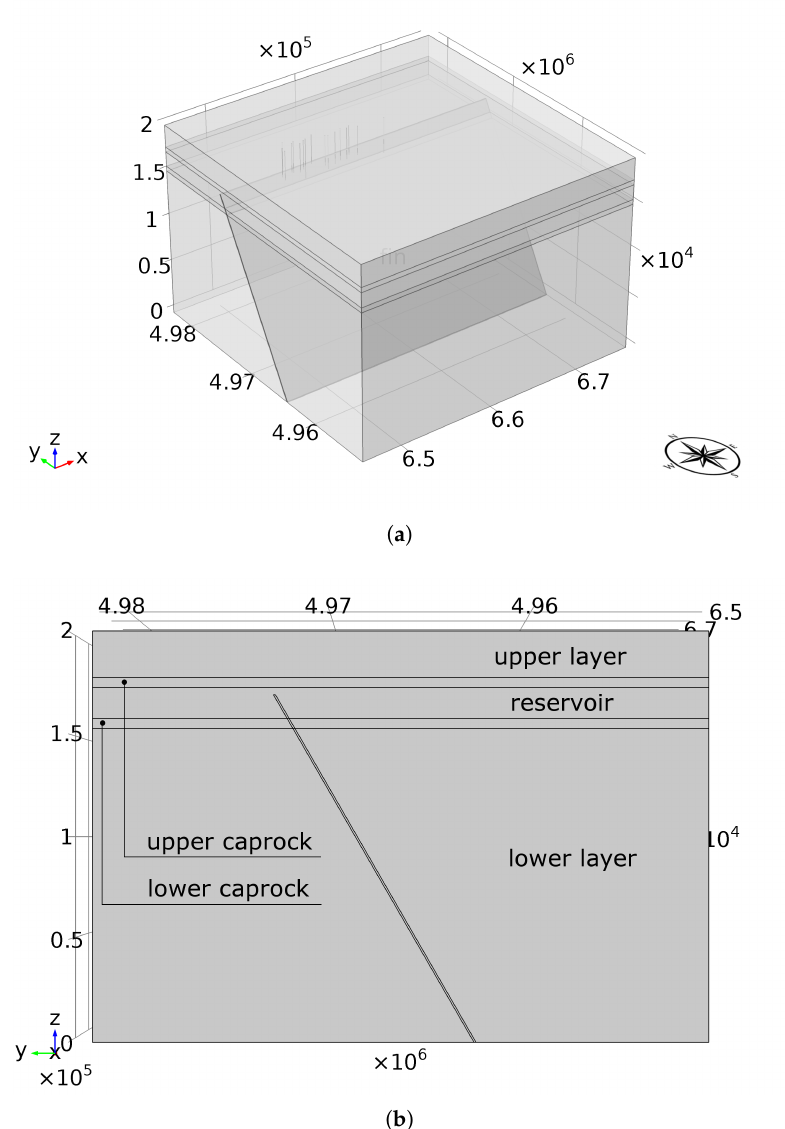
Figure 21. Blind Mirandola fault and Cavone oilfield modeling: geometry ( a ), and lateral view of the 3D model ( b ); dimensions are 10 5 m in x , 10 6 m in y and 10 4 m in z